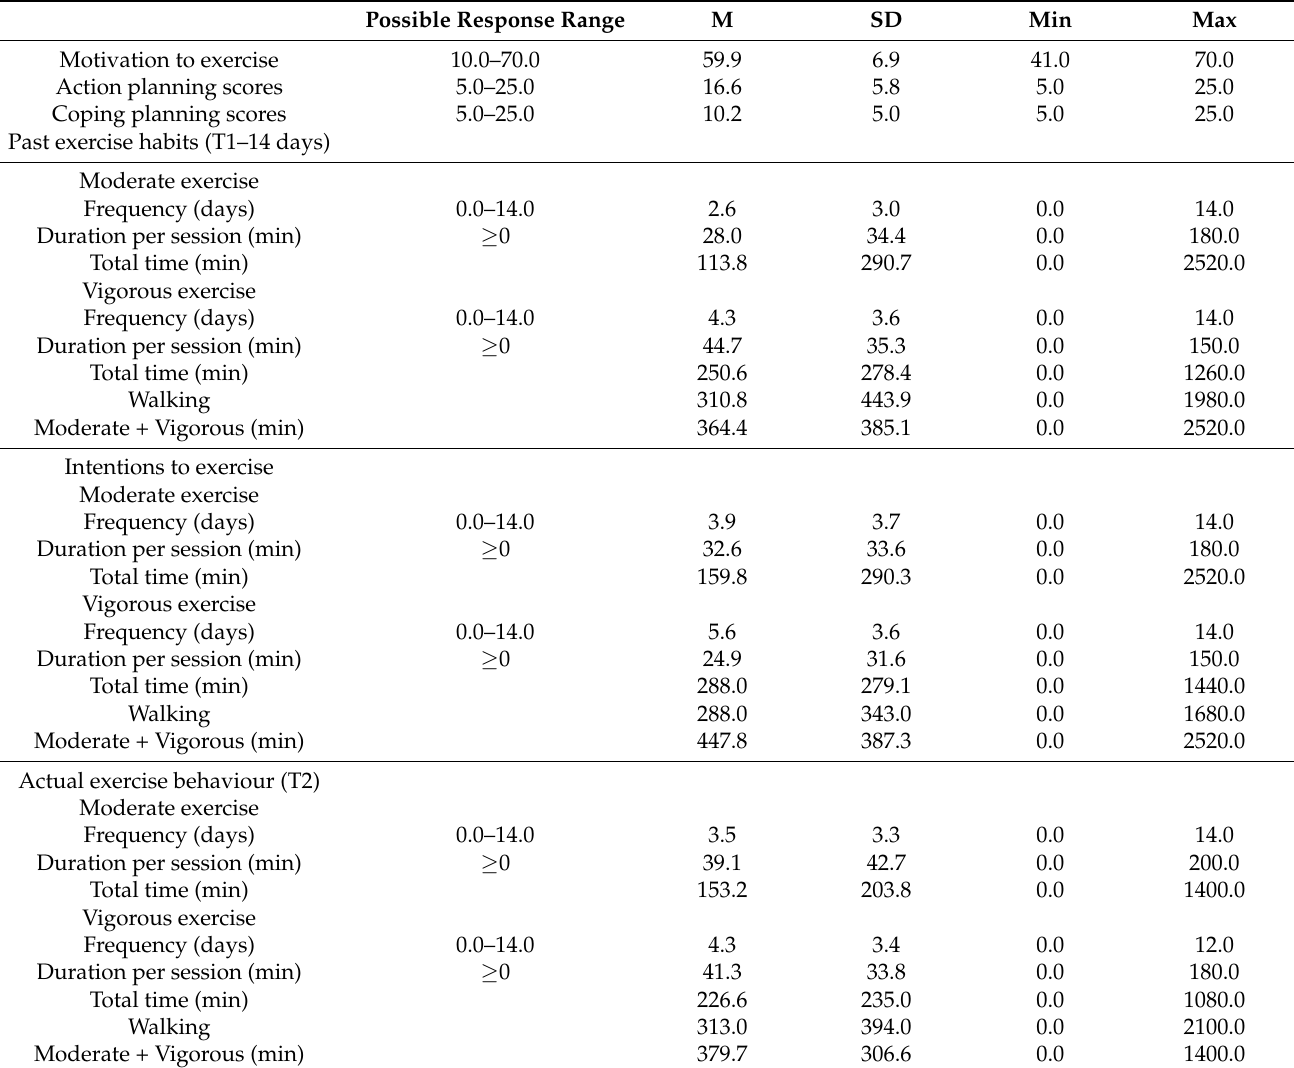
Table 2. Descriptive statistics for